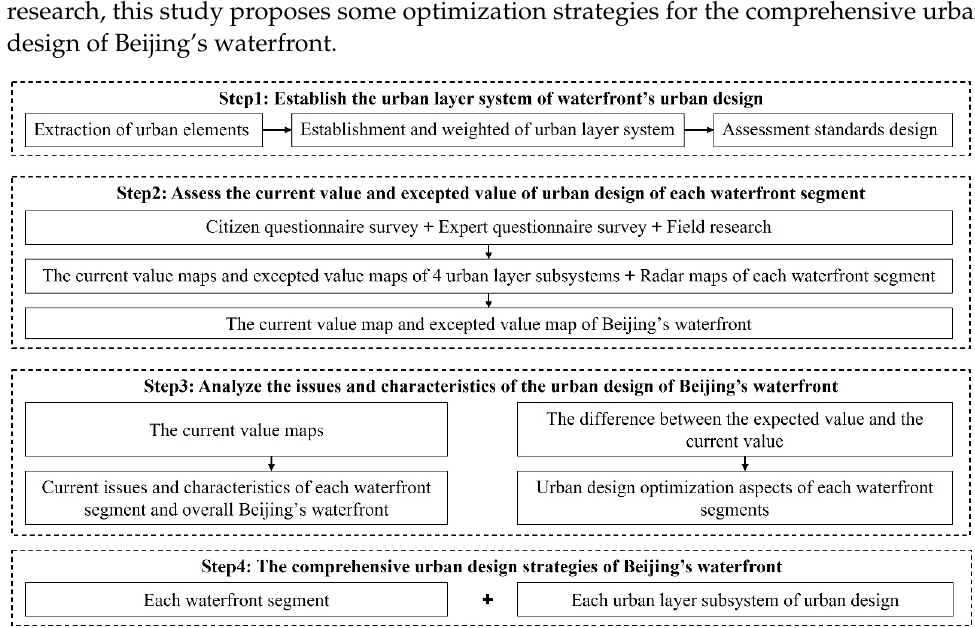
Figure 1. Study framework.